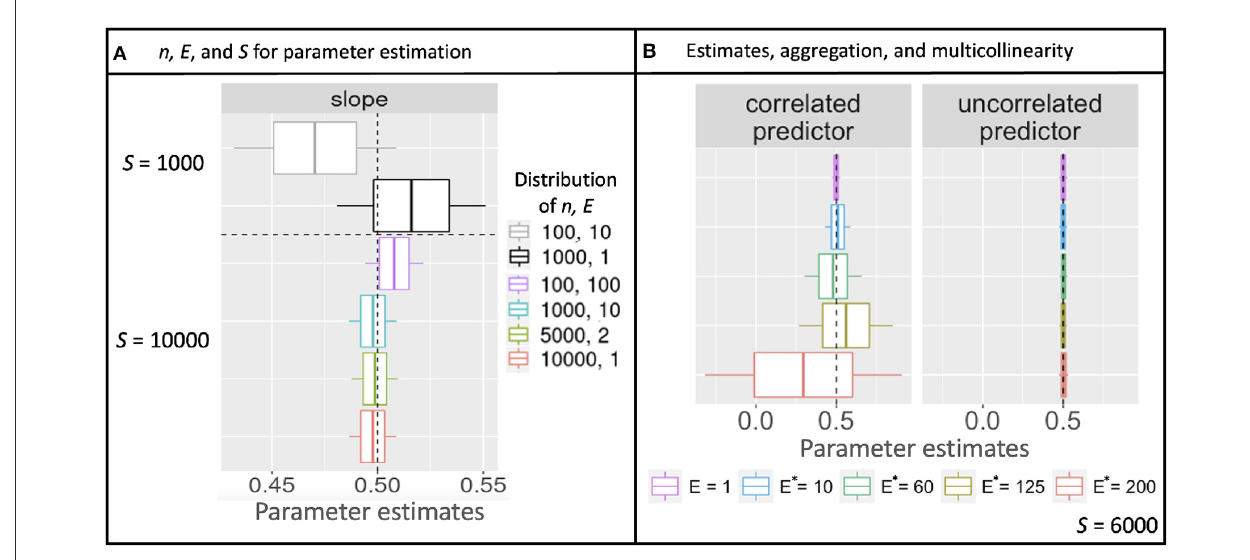
FIGURE2 Uncertainty in slope estimates from simulated Poisson data. (A) Posterior mean parameter estimates diverge from the value used to simulate data (vertical dashed line) due to stochasticity, but parameter uncertainty (68% boxes and 95% whisker widths) are fixed for a given total sampling effort S , regardless of how it is partitioned by sample size n vs. observation effort E . (B) Where there is a correlated predictor (left panel), uncertainty in parameter estimates increases with aggregated effort E ∗ , despite the same total effort S , but not for the uncorrelated predictor (right).